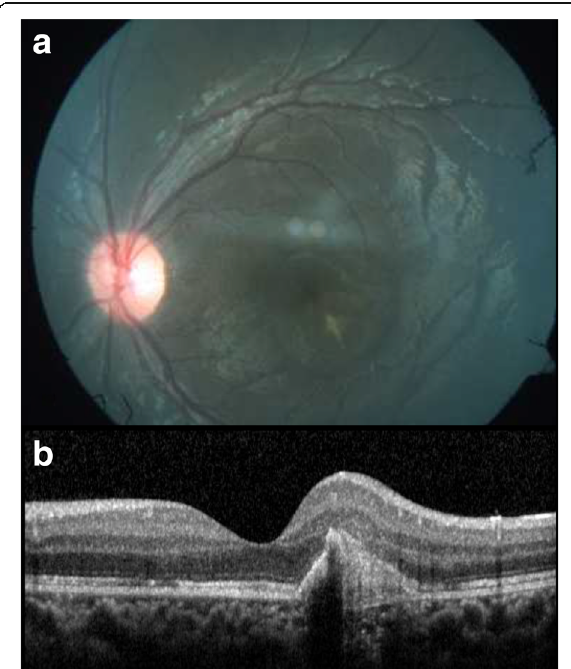
Fig. 3 a Color fundus photograph of the left eye at 1-month follow- up. b Optical coherence tomography showing the scarred choroidal neovascular membrane and resolution of subretinal